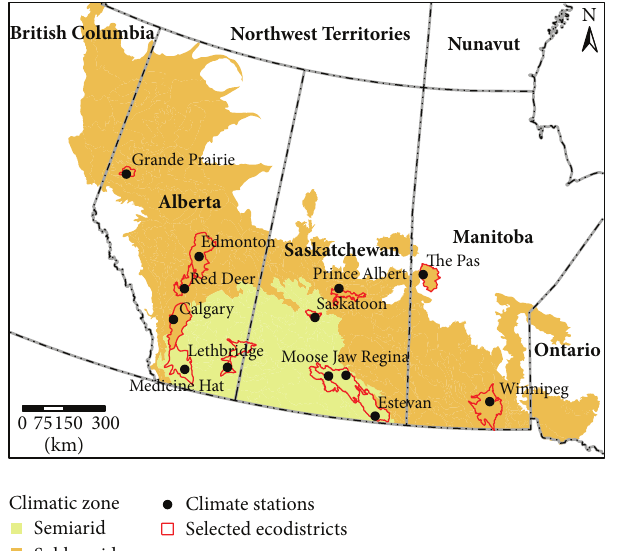
Figure 1: Map of the study area with representative climate stations in the subhumid and semiarid climatic zones. Climatic zones were delineated based on precipitation to potential evapotranspiration (P/PE) ratio (subhumid if P/PE ≥ 0.52, semiarid if P/PE < 0.52). Ecodistricts containing a selected climate station are highlighted in red. Land, crop and summerfallow area for these ecodistricts are given in Table